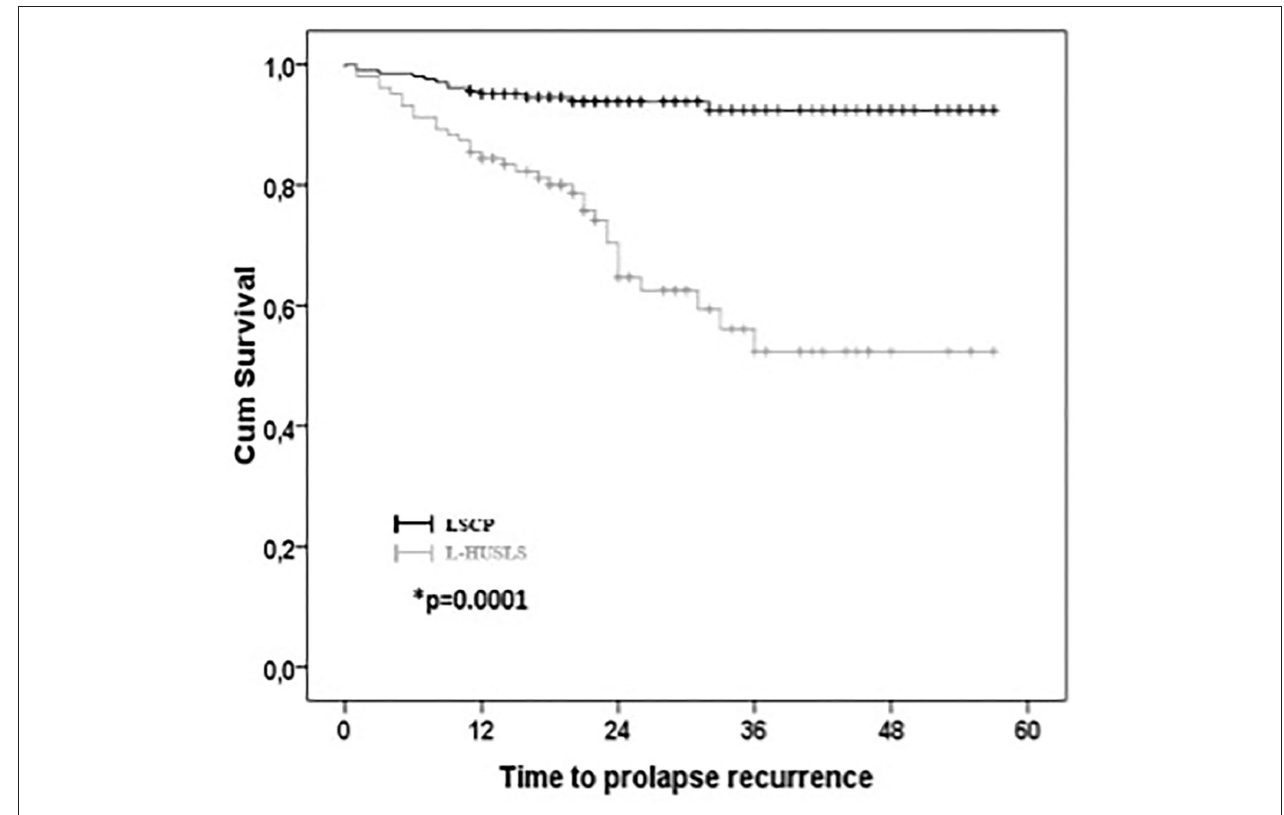
FIGURE 2 | Kaplan–Meier survival curves for anatomical recurrence. Kaplan–Meier curves of objective recurrence in the whole